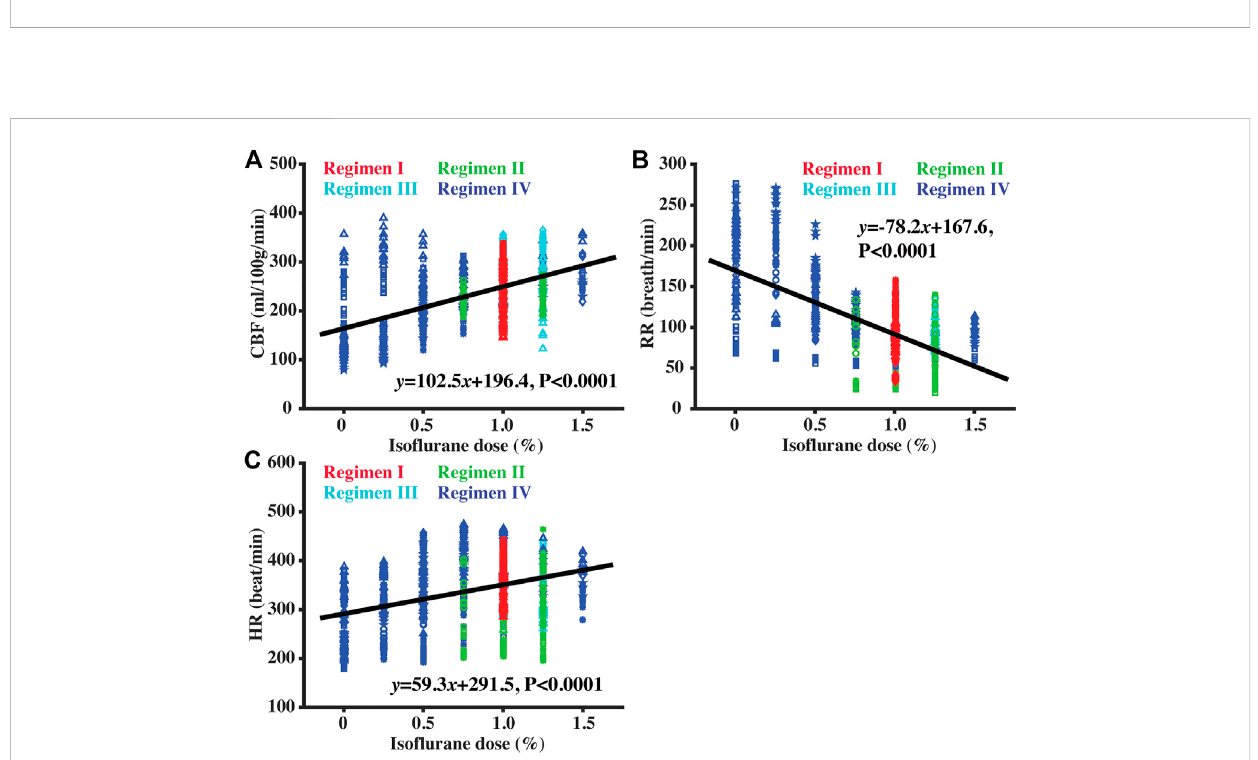
concentration. Accordingly, it is expected that CBF change during an anesthesia regimen is a dynamic process. The present study found that RR and HR are important parameters to explain